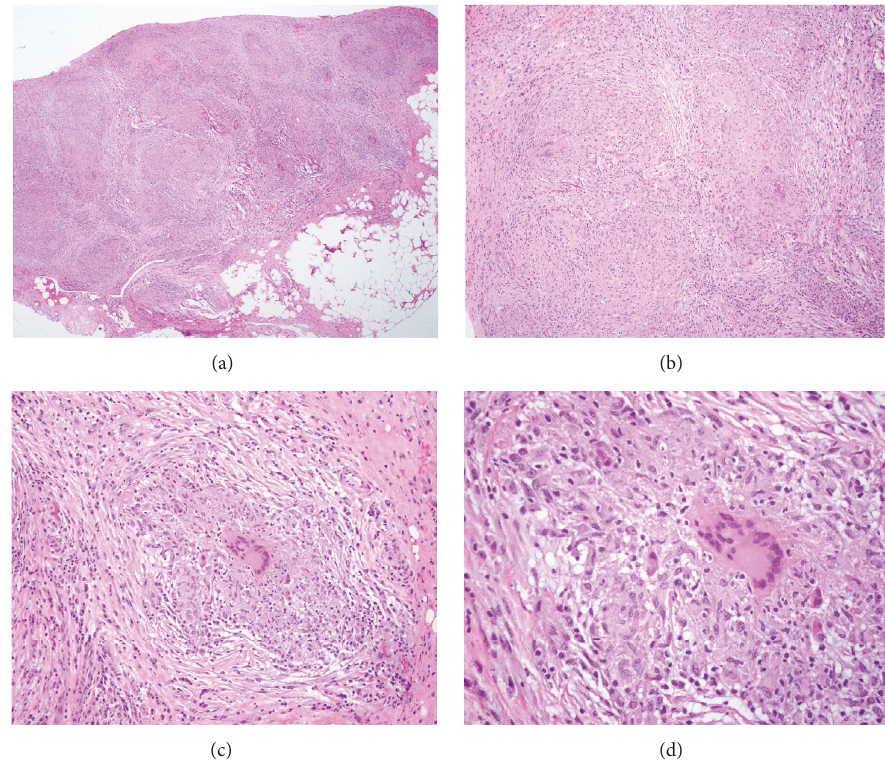
Figure 2: Histopathological analysis. The specimen contains noncaseating granulomata composed of aggregates of epithelioid histiocytes and Langerhans giant cells surrounded by chronic inflammation. The special stain AFB is negative for acid fast organisms and the special stain Gomori Methenamine Silver (GMS) is negative for organisms. (a) Granuloma H&E staining (4x). (b) Granuloma H&E staining (10x). (c) Granuloma H&E staining (20x). (d) Granuloma H&E staining